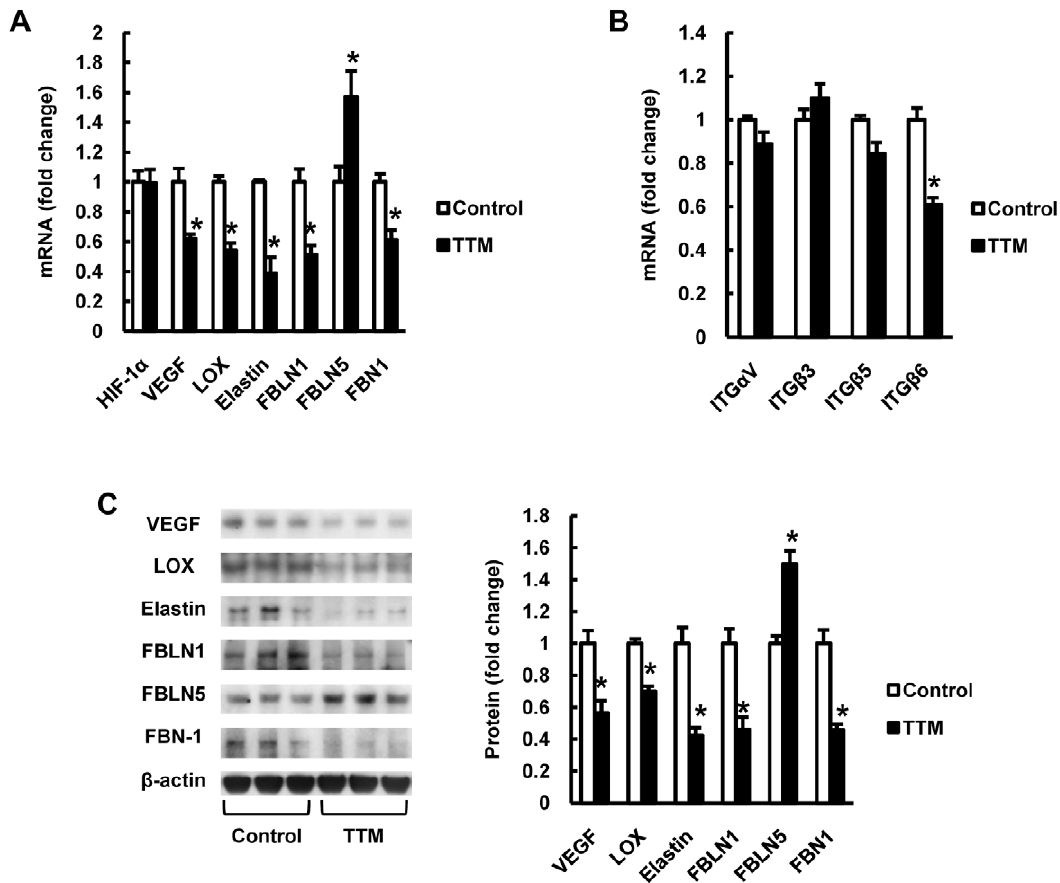
Figure 3. Copper depletion decreases VEGF, lysyl oxidase (LOX), elastin, fibullin-1 (FBLN1), fibrillin-1 (FBN1) and integrin b 6 expression in rat lungs. (A) The bar graphs show HIF-1a, VEGF, LOX, elastin, FBLN1, FBLN5 and FBN1 mRNA expression in TTM treated rat lungs measured by RT-PCR analysis, and quantified as a ratio of the expression in vehicle treated rats. (B) The bar graphs show integrin (ITG) a V, b 3, b 5 and b 6 mRNA expression in TTM treated rat lungs.(C) Representative Western blot analysis of VEGF, LOX, FBLN1, FBLN5, FBN1 and ß-actin in lung protein extracts from TTM treated rats. The bar graph shows the ratios of VEGF, LOX, FBLN1, FBLN5, FBN1protein expression relative to controls. Data are expressed as mean 6 SE (n=6). *P , 0.05 versus control.